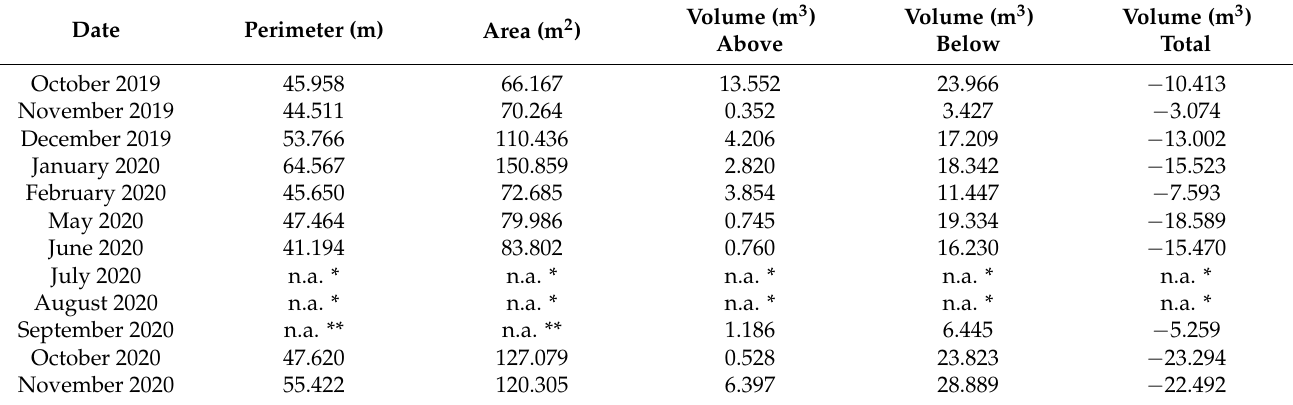
Table 2. Multitemporal sizes of the bubbling mud pool. The perimeter is related to a seasonal trend.